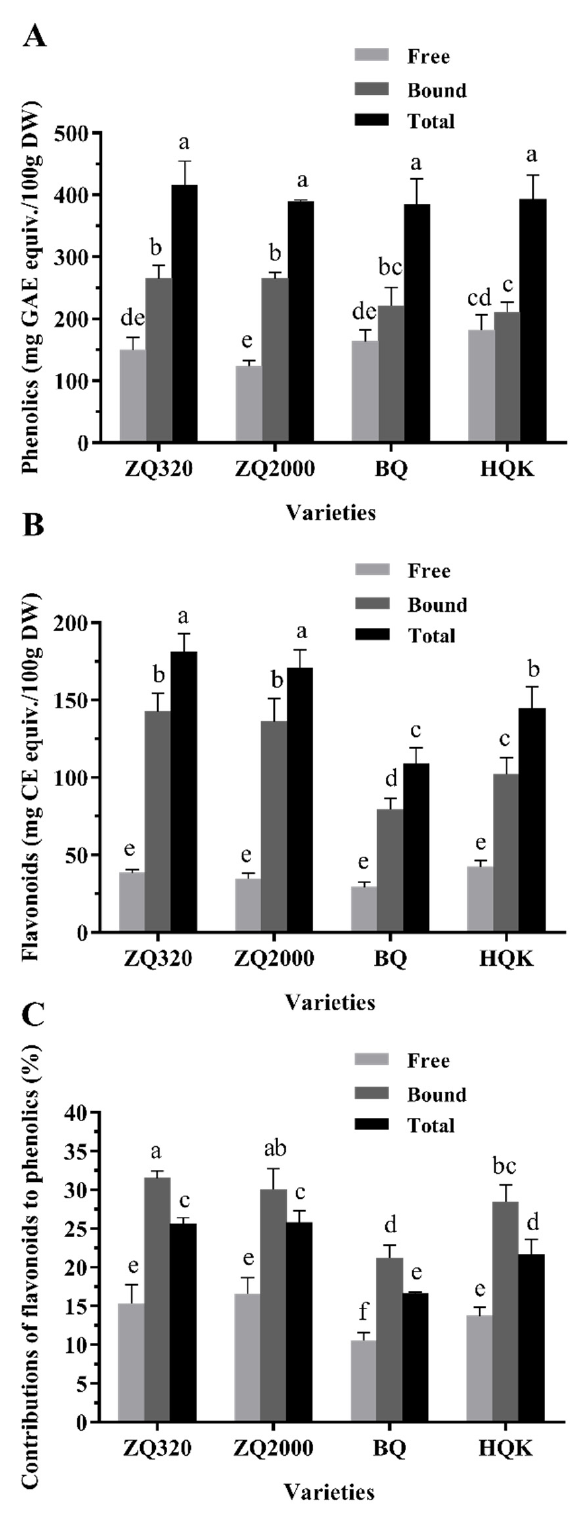
Figure 1. Total phenolic ( A ) and flavonoid contents ( B ) and contributions of flavonoids to phenolics ( C ) of the free, bound, and total fractions of four highland barley varieties (mean ± SD, n = 3). Values with different letters in each bar differ significantly at p < 0.05.